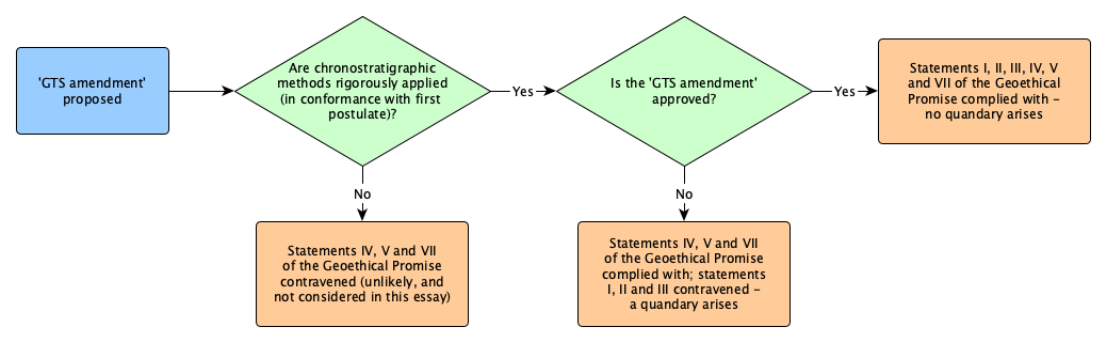
Figure 1. Possible outcomes and geoethical consequences of the ‘GTS amendment’ proposal. 330